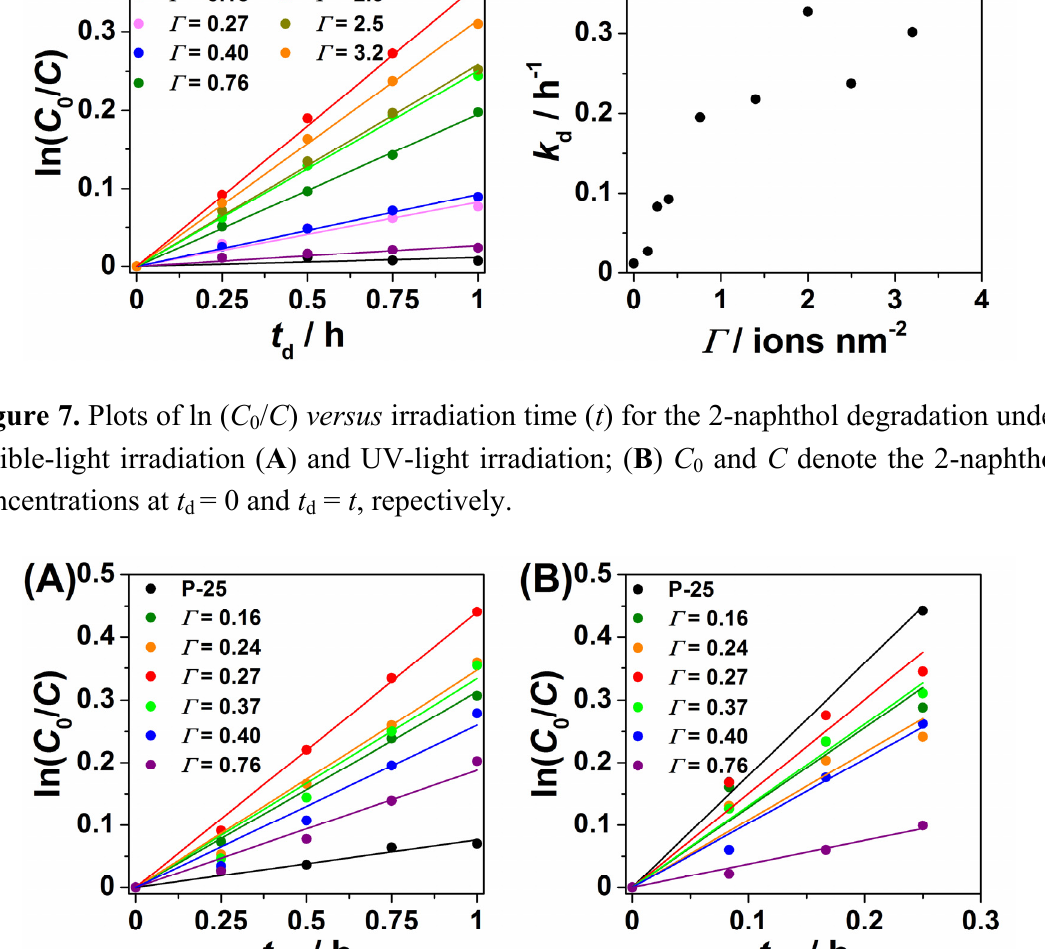
Figure 6. ( A ) Plots of ln ( C 323 K in the dark: C repectively; ( B ) Plots of rate coefficient ( k